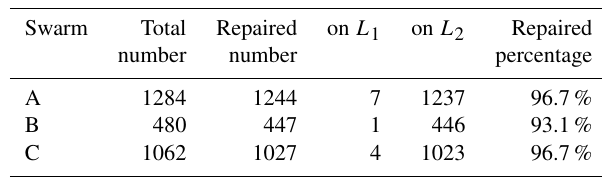
Table 2. Statistics of the cycle slips for Swarm A, B and C during 1